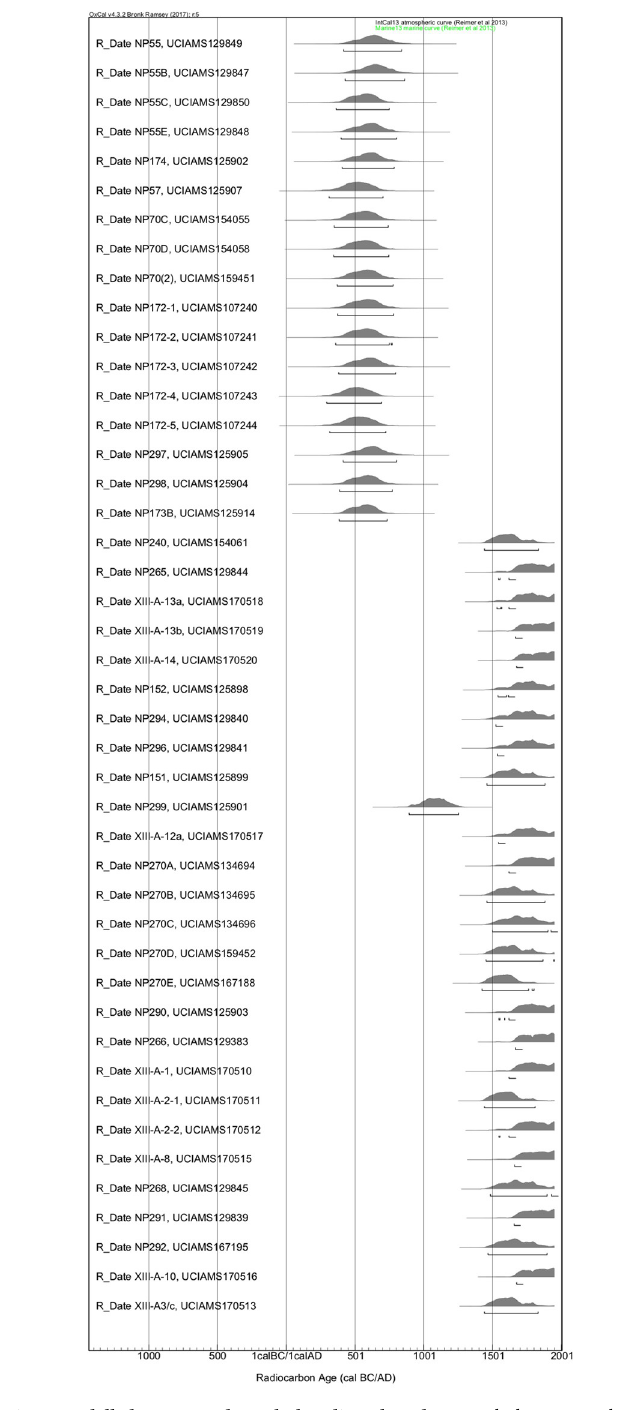
Fig 2. Modelled Dorset and Beothuk radiocarbon dates. Includes previously published dates from Raghavan et al. 2014 and Duggan et al. 2017.